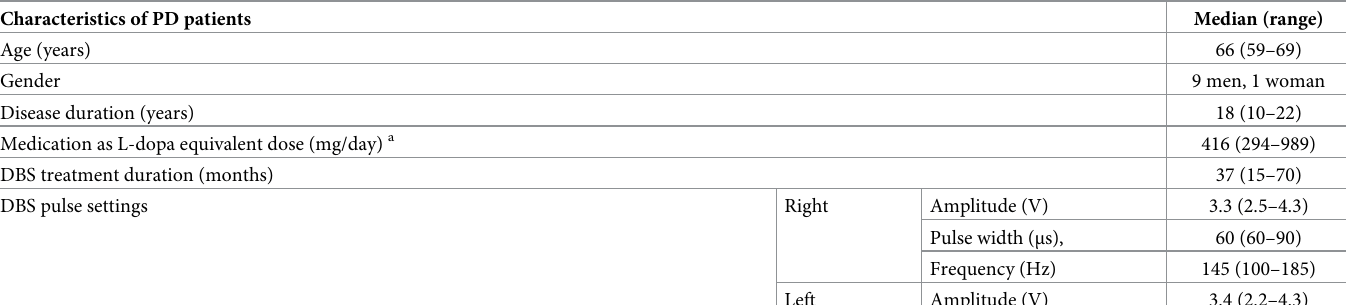
Table 1. Characteristics of Parkinson’s disease